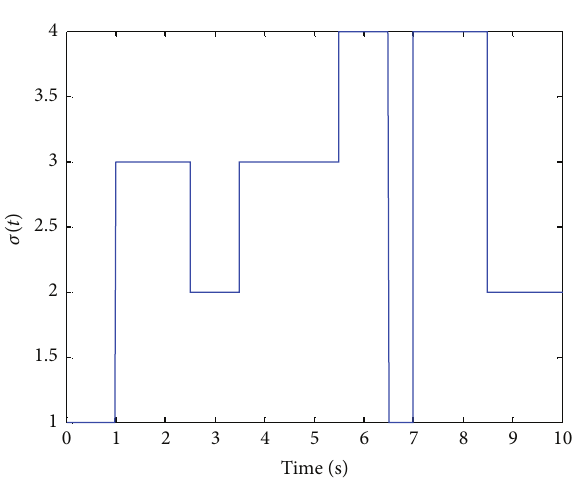
Figure 2: Switching signal 𝜎(𝑡)